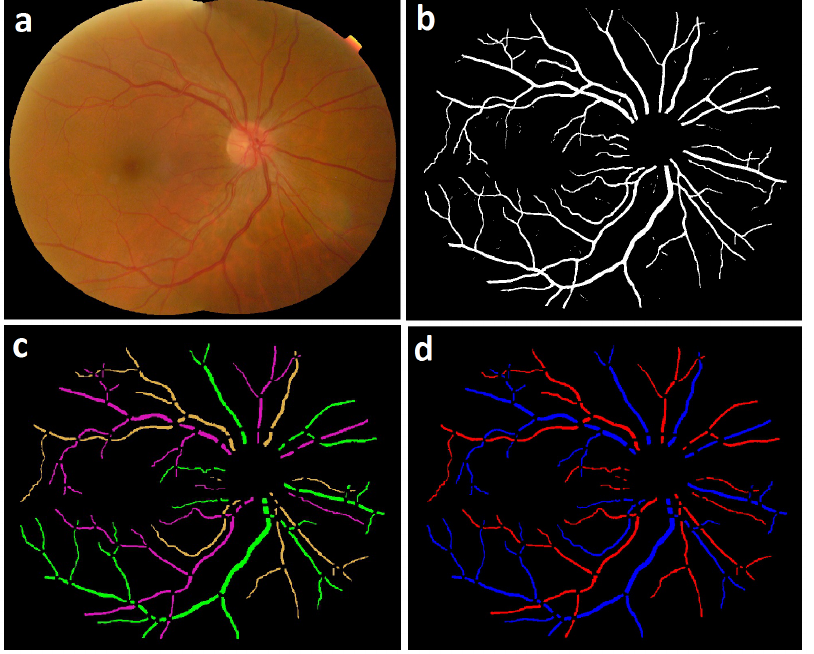
Figure 12. Image example: a) Fundus image b) Vessel probability image c) Structural mapping d) AV Classification. doi:10.1371/journal.pone.0088061.g012 PLOS ONE |